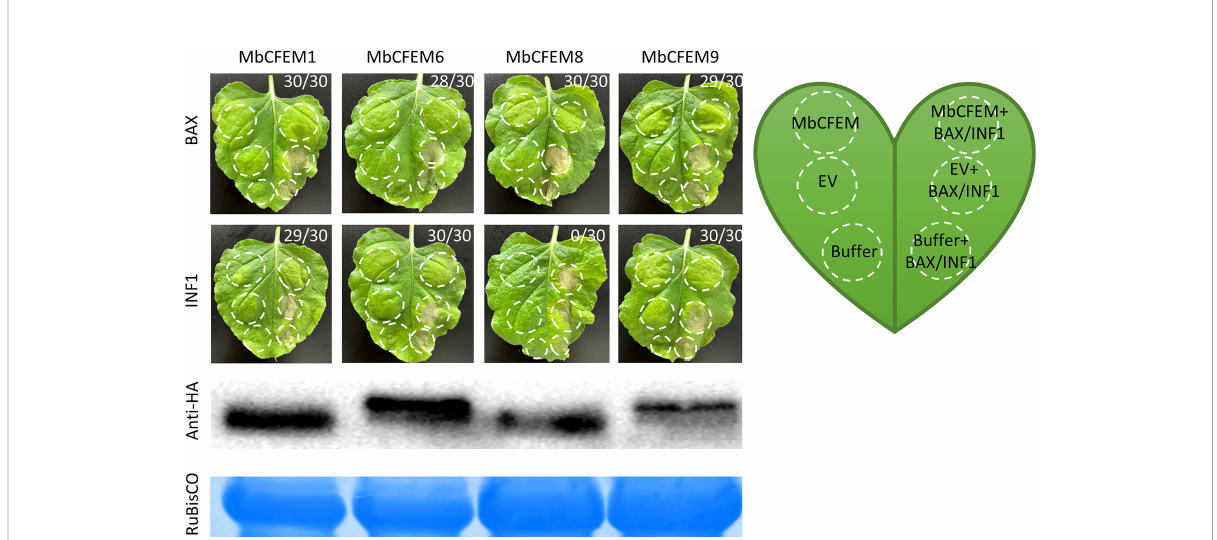
FIGURE 6 Suppression of BAX/INF1-triggered cell death on N. benthamiana leaves. The Agrobacterium suspension carrying each of the tested candidate MbCFEM effectors (MbCFEM1, MbCFEM6, MbCFEM8, and MbCFEM9) was in fi ltrated into tobacco leaves followed by the in fi ltration of the mouse protein BAX or the Phytophthora infestans elicitin infestin 1 (INF1) in the same position after 24 h to examine the suppression function of the hypersensitive response. All the in fi ltration positions were illustrated in the model leaf. Agroin fi ltration was performed on tobacco leaf with Agrobacterium tumefaciens carrying MbCFEMs, MbCFEMs with BAX/INF1, EV (empty vector), EV with BAX/INF1, in fi ltration buffer, and in fi ltration buffer with BAX/INF1. EV and in fi ltration buffer were used as negative controls while EV with BAX/INF1 and in fi ltration buffer with BAX/INF1 as positive controls. The results were photographed 4 days post inoculation (dpi). Numbers, e.g., 30/30, indicate that 30 of 30 in fi ltrated leaves exhibited suppression of the cell death triggered by BAX or INF1 on the MbCFEM effectors overexpressed site (MbCFEM+BAX/INF1). Western blot was performed to con fi rm the expression of all the candidate MbCFEM effectors using an anti-HA (hemagglutinin) antibody. Experiments were repeated three times with similar